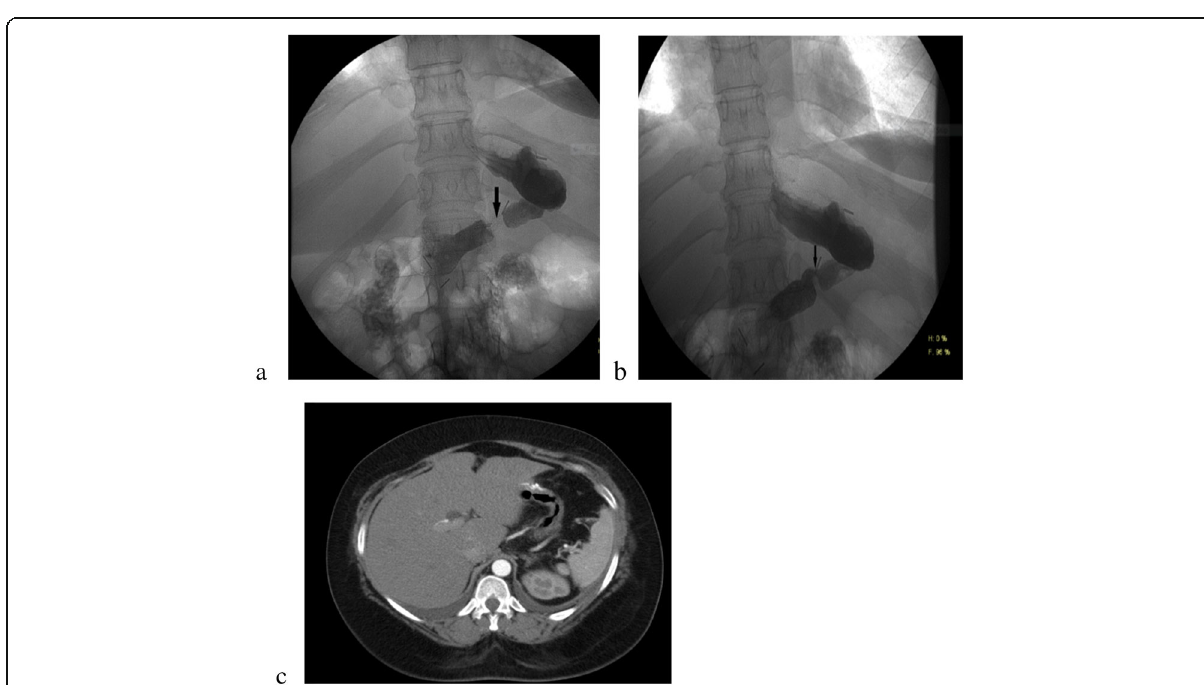
Fig. 13 A fifty-two-year-old male patient presented 1 year post-lap. sleeve gastrectomy by abdominal pain and vomiting. a , b UGIS films showed stricture at mid-body of the stomach with delayed passage of the contrast at this part. c MSCT axial cuts show stricture of mid-sleeved stomach. Diagnosis: stricture of mid-sleeved stomach more evident in UGSI